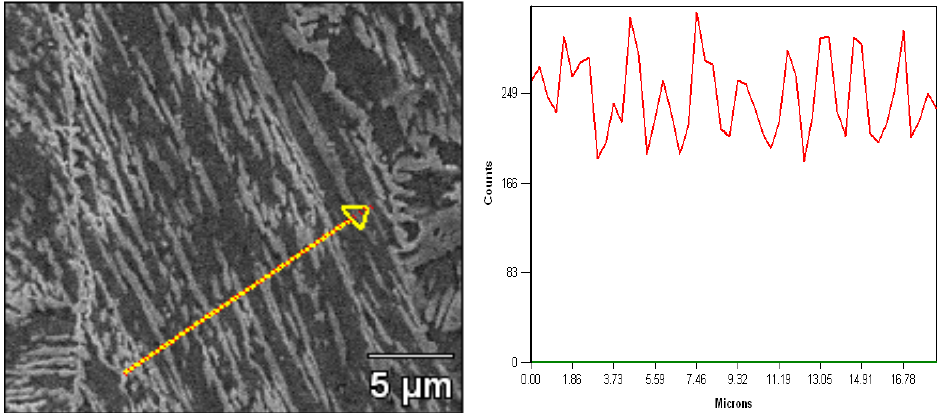
Figure 7. SEM micrograph of the samples tempered at 620 ◦ C for 32 h and the Ni element distribution of line scan spectrum EDX in the microstructure.